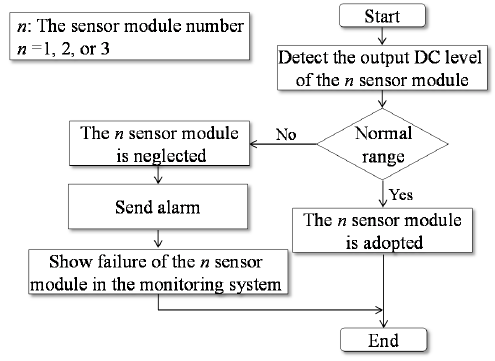
Figure 6. Flowchart of sensor module condition function unit.